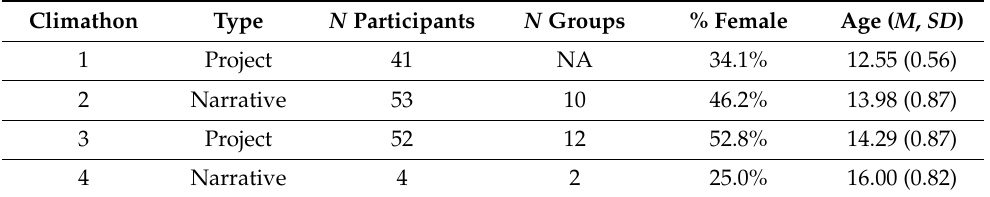
Table 1. Climathons’ and samples’ characteristics (Climathon type, number of participants who completed the questionnaire, number of groups, share of participants who described themselves as female, and participants’